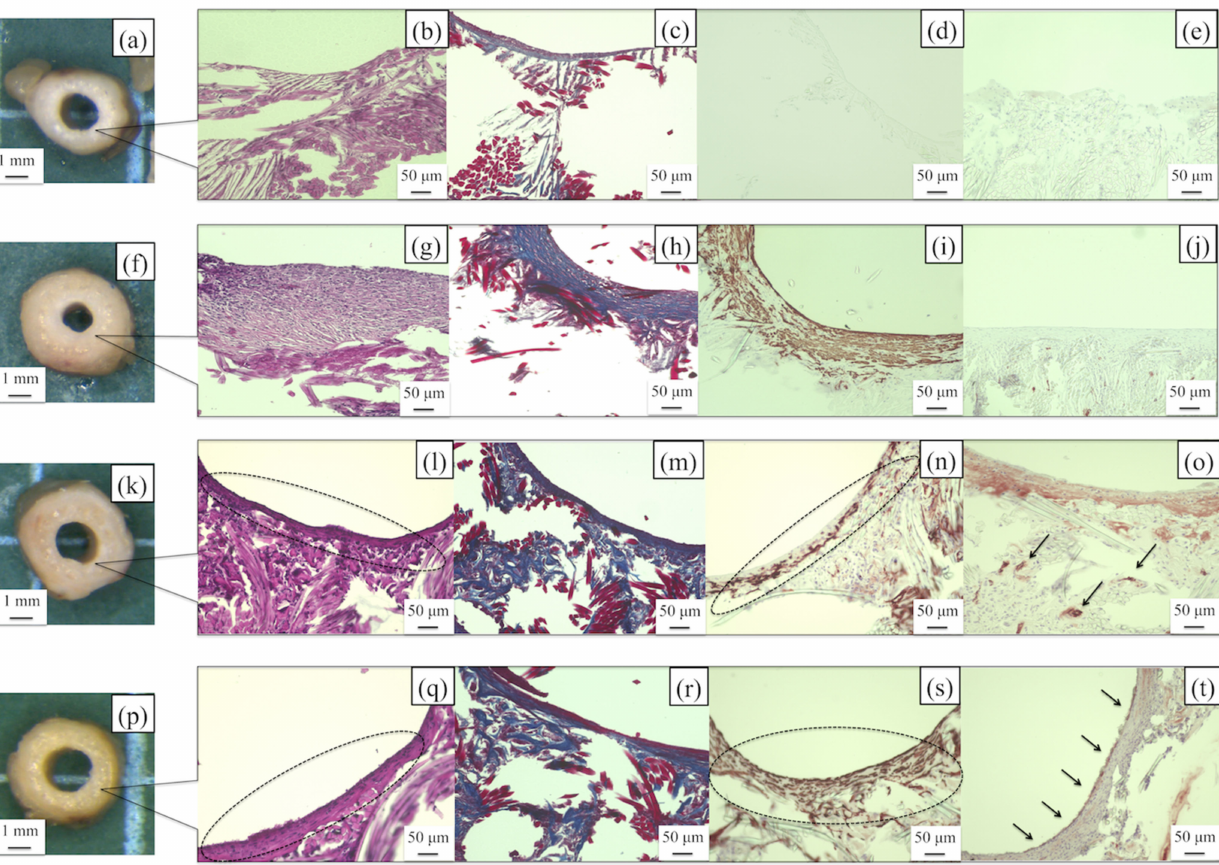
Figure 11. Photographs of the microscopic findings of the PU- ( a ) and PU-SF-coated SF grafts ( k ) at 2 weeks after implantation and the PU- ( f ) and PU-SF-coated grafts ( p ) at 4 weeks after implantation. Histological cross-sectional images of the PU-coated graft at 2 weeks after implantation: the PU-coated graft after ( b ) H&E, ( c ) EVG, and ( d ) α -SMA staining, and ( e ) the PU-SF-coated graft after CD31 staining. Histological cross-sectional images of the PU-coated graft at 4 weeks after implantation: the PU-coated graft after ( g ) H&E, ( h ) EVG, ( i ) α -SMA, and ( j ) CD31 staining. Histological cross-sectional images of the PU-SF-coated graft at 2 weeks after implantation: the PU-SF-coated graft after ( l ) H&E, ( m ) EVG, ( n ) α -SMA, and ( o ) CD31 staining. Histological cross-sectional images of the PU-SF-coated graft at 4 weeks after implantation: the PU-SF-coated graft after ( q ) H&E, ( r ) EVG, ( s ) α -SMA staining, and ( t ) CD31 staining. The part enclosed by the dotted line shows the intima. The arrows indicate that vascular endothelial cells adhered to the inner surfaces of the